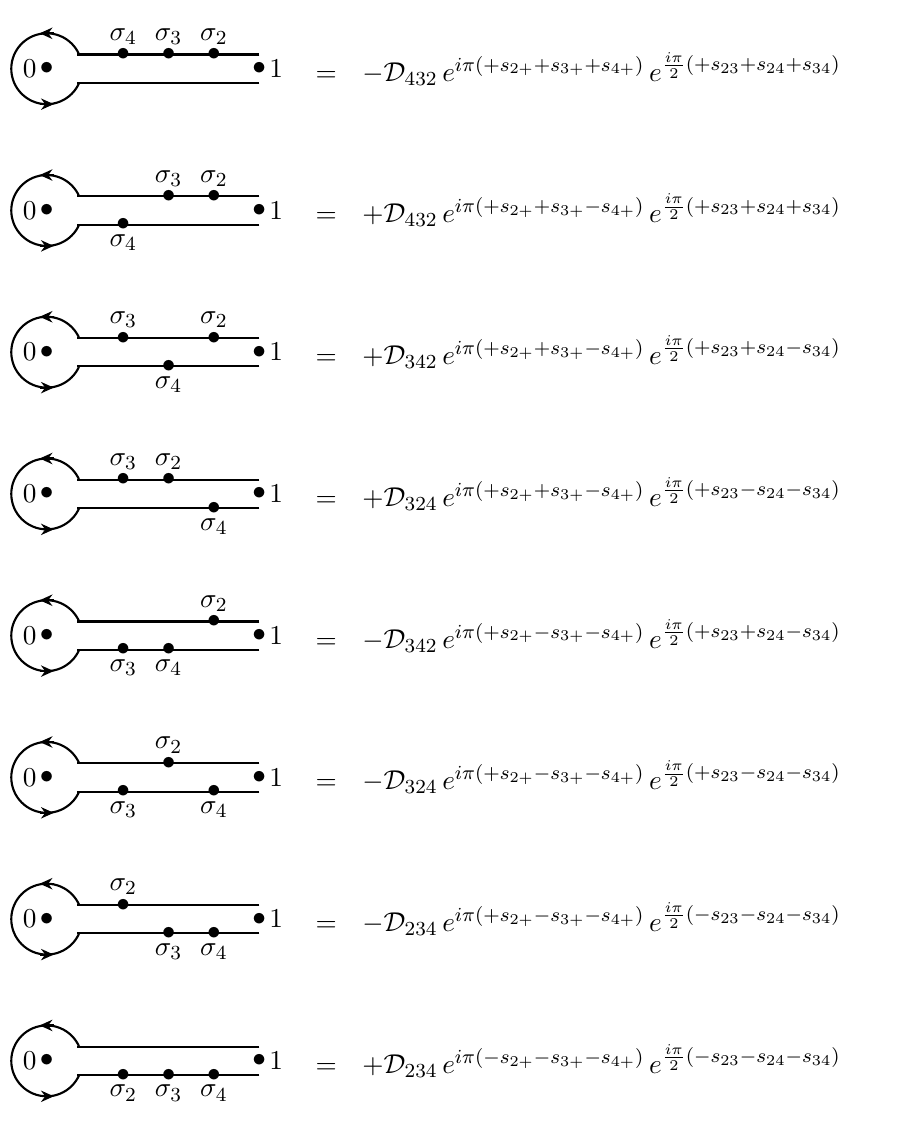
Figure 6 . Genus-zero contributions D ijk to the degenerate genus-one integral over the four-point cycle C 1234 = f 0 < z 2 < z 3 < z 4 < 1 g